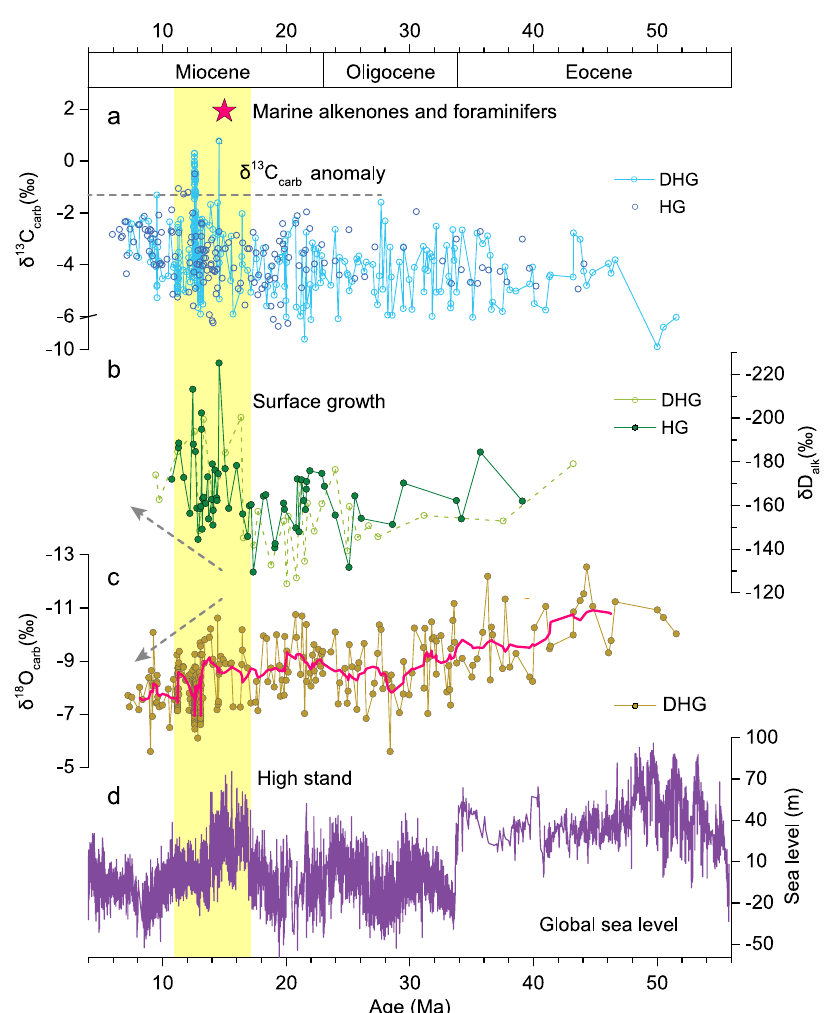
Fig. 3 Regional records supporting mid-Miocene seawater incursion into the Qaidam Basin. a DHG and HG carbonate δ 13 C records, with the dashed line showing elevated δ 13 C values during the mid-Miocene. b DHG and HG leaf wax δ D records. c DHG carbonate δ 18 O record 24 , with a superimposing 10-point smoothing line (red). d Global sea level record 45 . In ( b and c ), the δ D and δ 18 O scales are inverted and the dashed lines indicate their divergent trends since the mid-Miocene. The yellow bar marks the mid-Miocene interval of possible seawater incursion and surface uplift afterwards, with the red star indicating the occurrences of marine alkenones (this study) and foraminifers 17 (Fig.